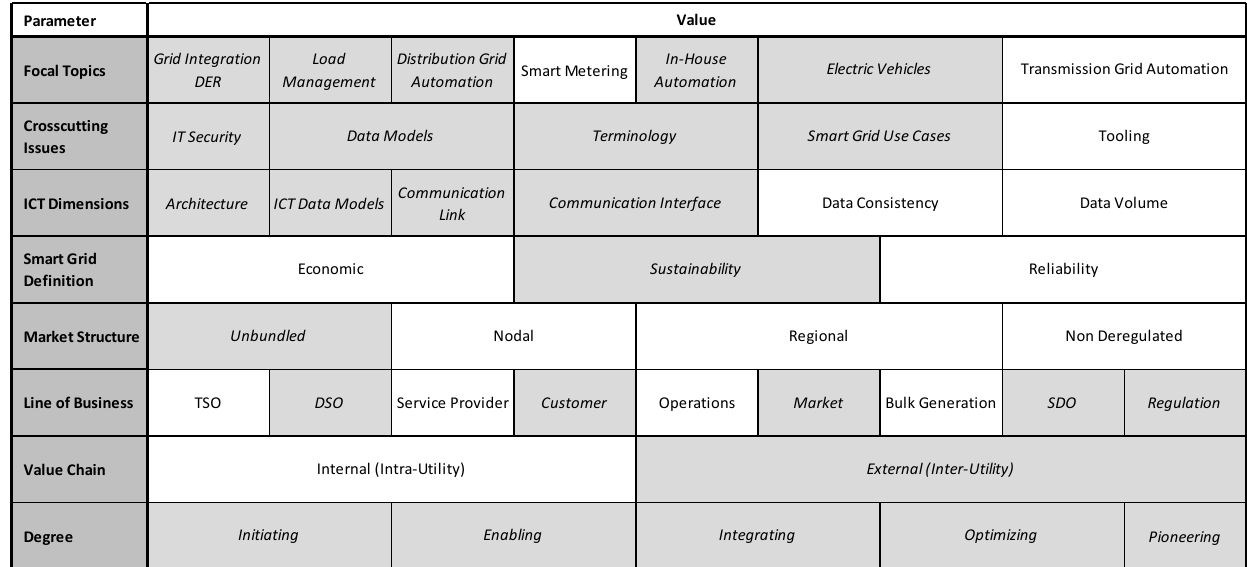
Figure 5 . Configuration for the German Roadmap E-Energy/Smart